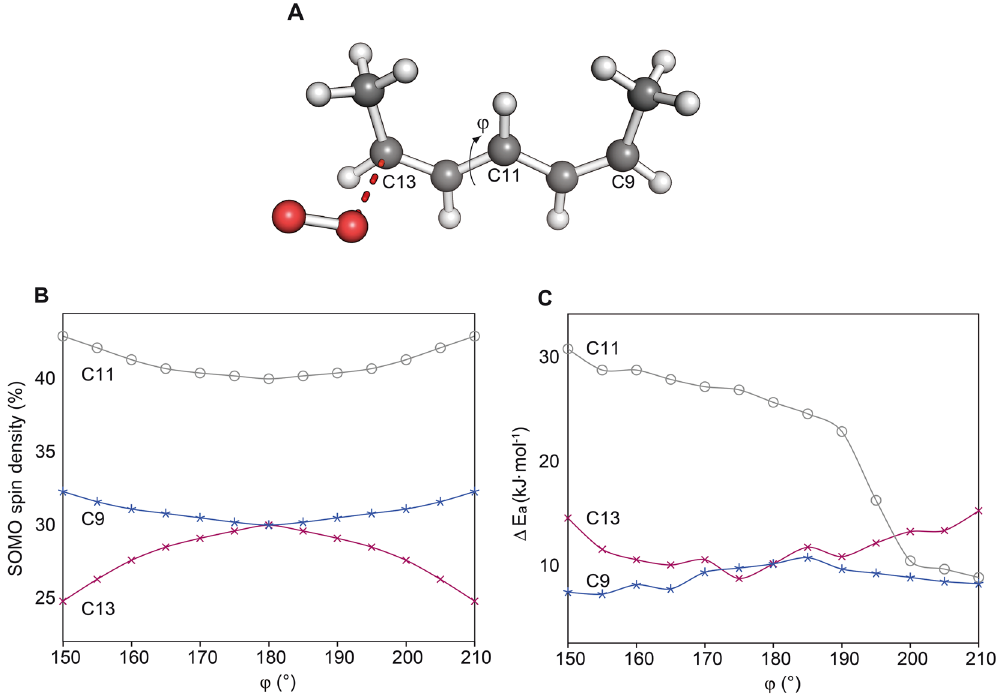
Figure 5. Model calculations exhibit different expectations for substrate spin density and activation barriers of oxygen attack. ( A ) Structure of the 2,5-heptadienyl radical which was used as a model system for the substrate. The correspondence to the carbon atoms of linoleic acid (18:2n-6), the varied dihedral angle ϕ and the side for oxygen attack are shown. ( B ) Spin density of the singly occupied molecular orbital (SOMO) on the three carbon atoms of interest for different dihedral angles ϕ . ( C ) Activation barriers for oxygen attack at the three carbon atoms of interest for different dihedral angles ϕ obtained by relaxed surface